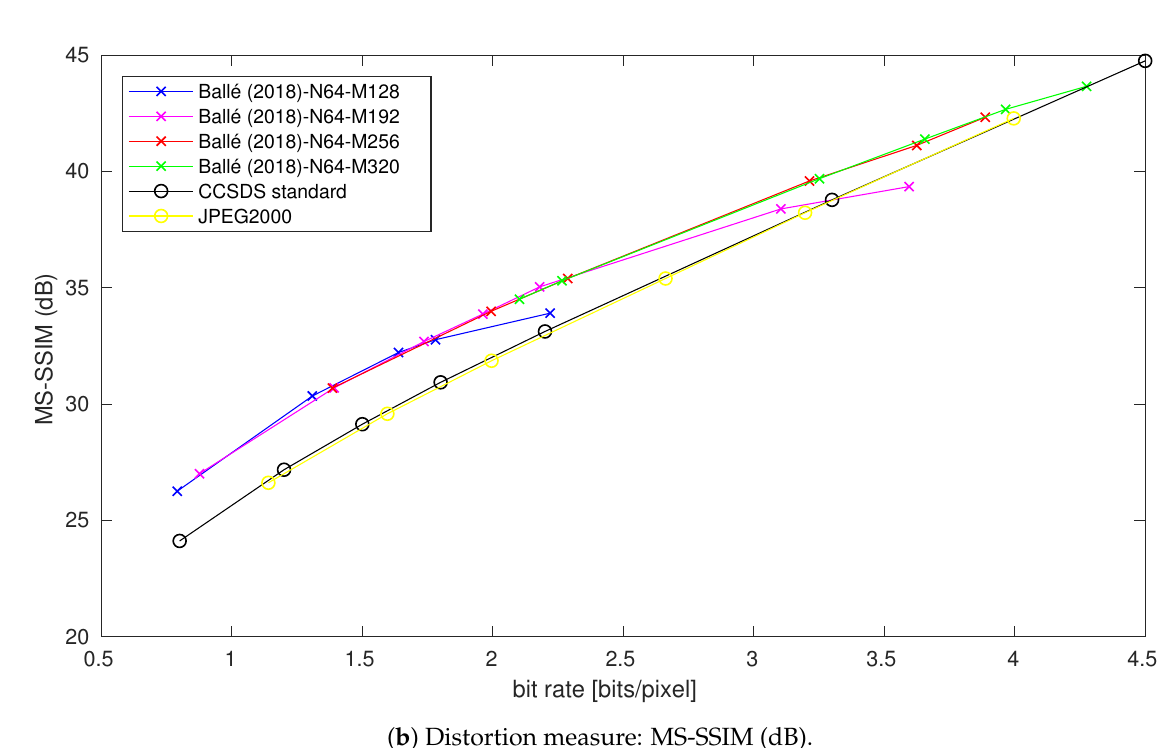
Figure 12. Impact of the bottleneck size in terms of MSE and MS-SSIM (dB) (derived as − 10log